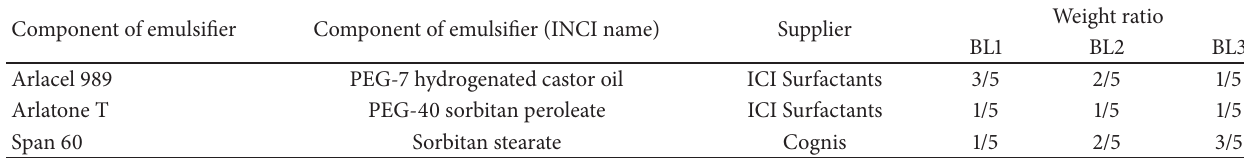
Table 2: Emulsifiers contained in the